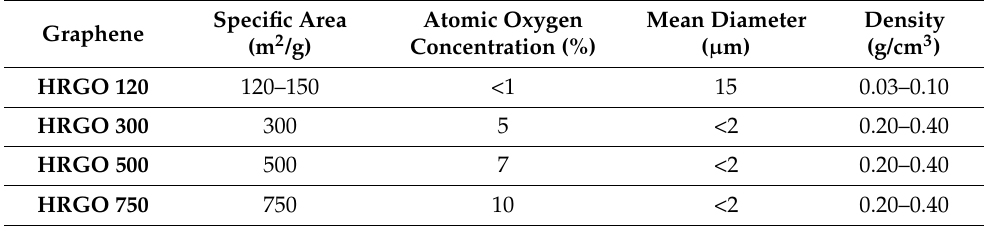
Table 2. Composition of XG Sciences highly reduced graphene oxide